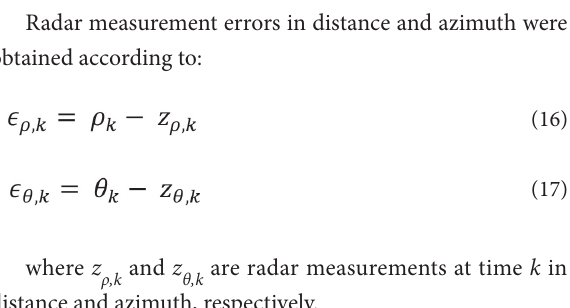
Figure 7. Samples of normalized error amplitude of IMMPDAF obtained with simulated measurements.